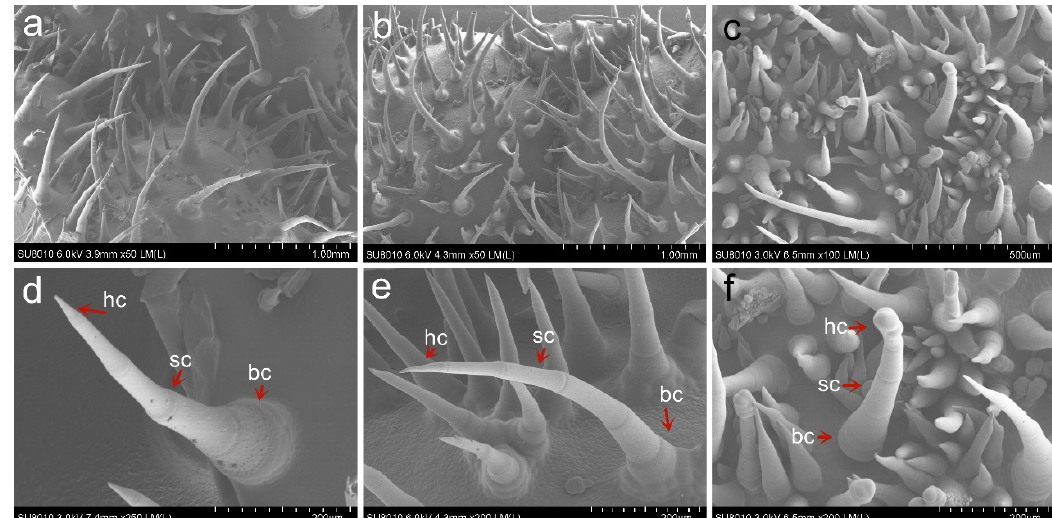
Figure 2. Cryo-SEM images of the leaf of WT, mt mutant and their F 1 progeny. Young leaves on the WT ( a , d ), F 1 progeny ( b , e ) and mt mutant ( c , f ) were observed. Hc = head cell, sc = stalk cell, bc = base